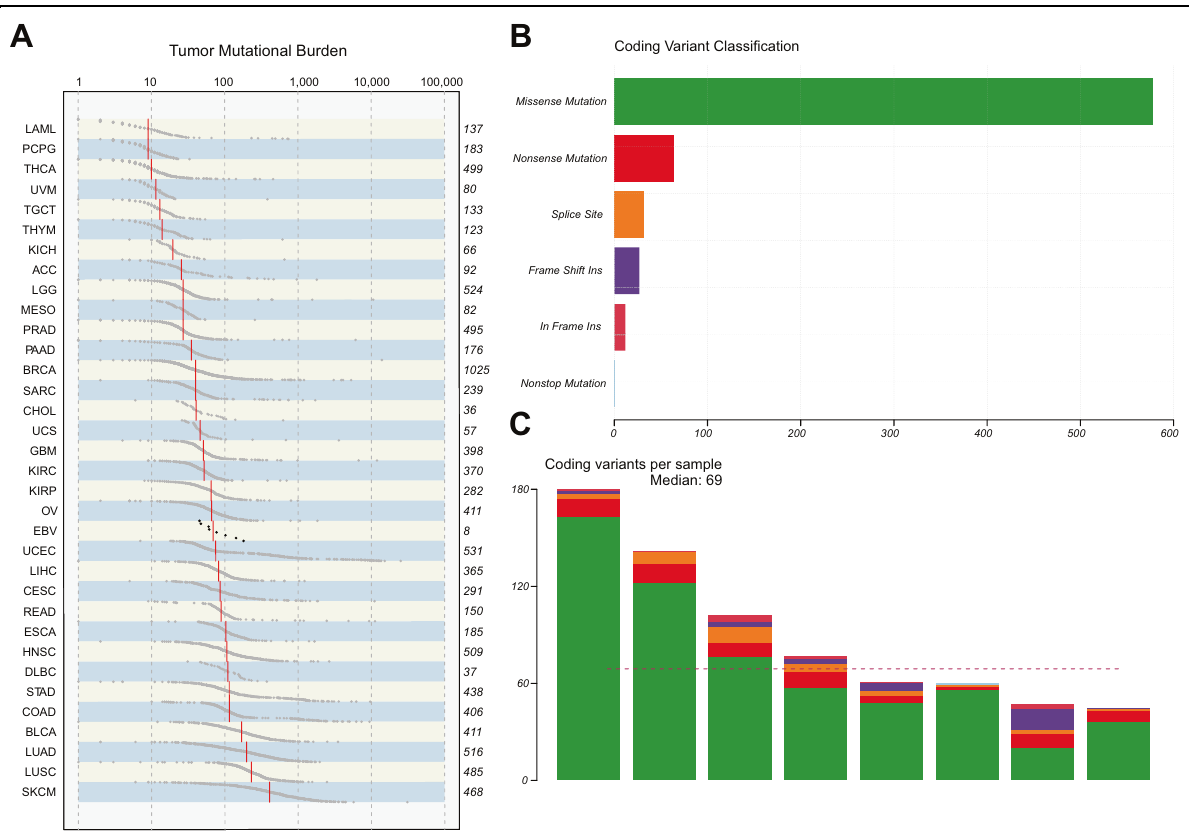
Fig. 1 Overview of mutational burden und subtypes. Panel ( A ) shows the mutational burden of EBV + DLBCL (NOS) against TCGA cohorts, the number of coding variants strati fi ed by variant classi fi cation is depicted in panel ( B ), and the number of non-silent mutations per sample is shown in ( C